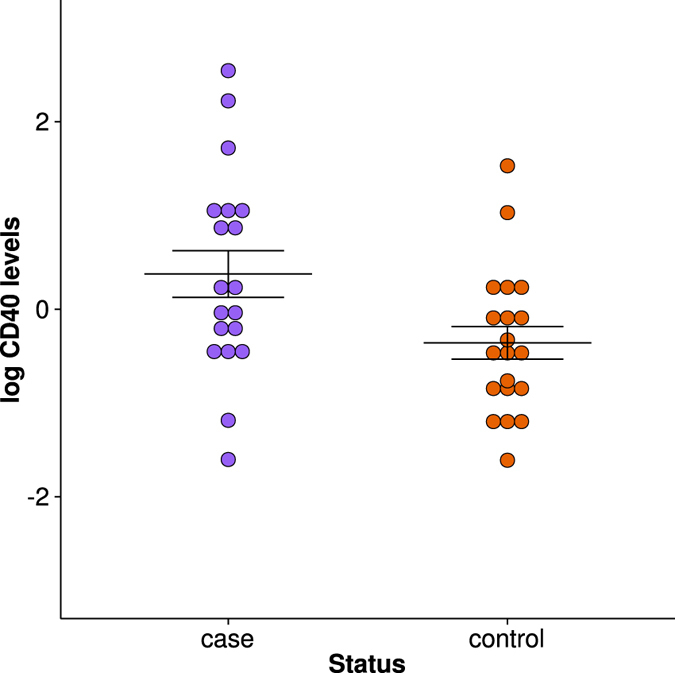
Plasma levels of CD40 in MS cases versus controls.